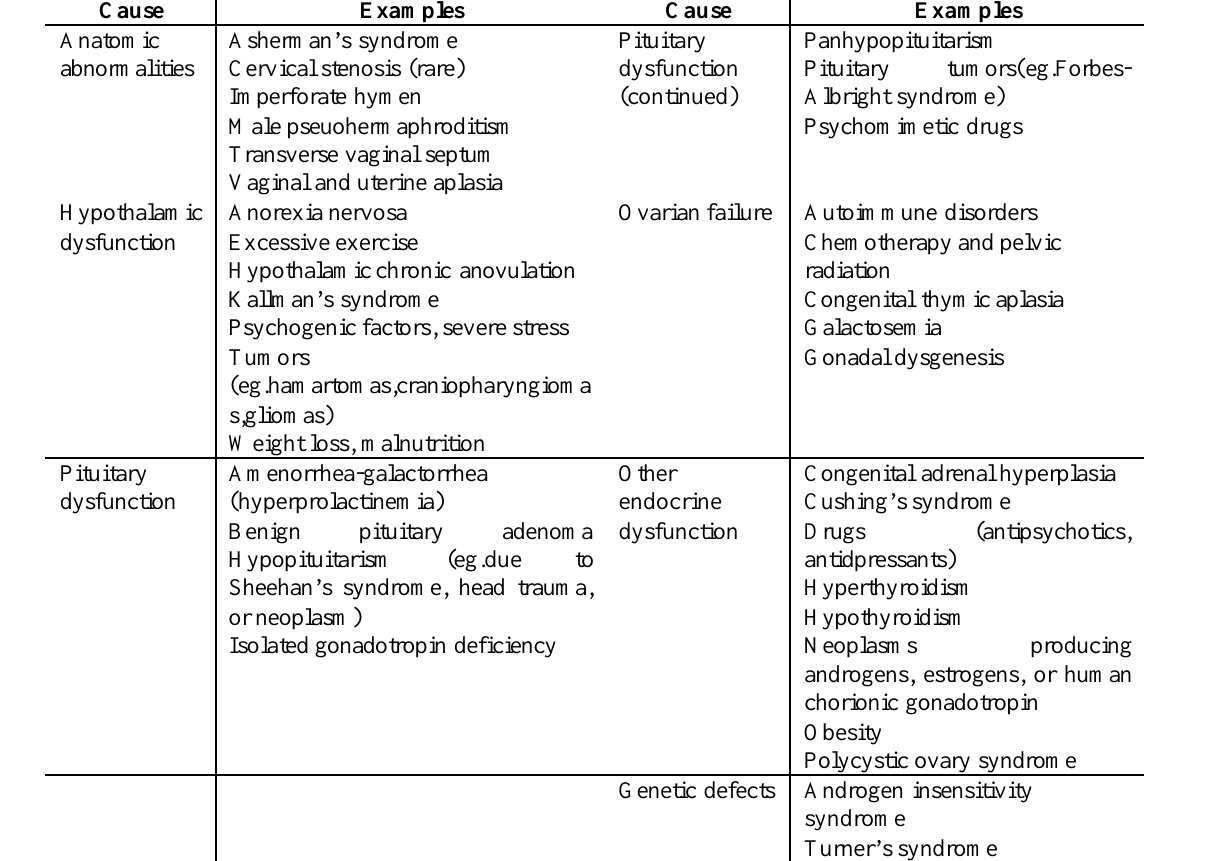
Table I : Causes of amenorrhea (Compiled from the Merck Manual)